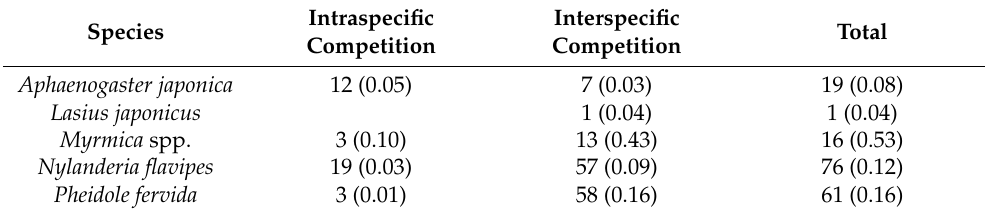
Table 4. Mortality (number of individuals (N) and percentage (%)) of ants from food